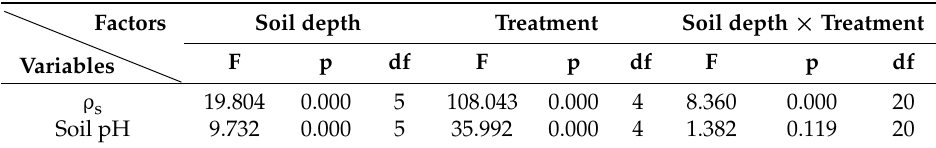
Table 5. Interaction effects between soil depth and treatment on soil bulk density ( ρ s ) and